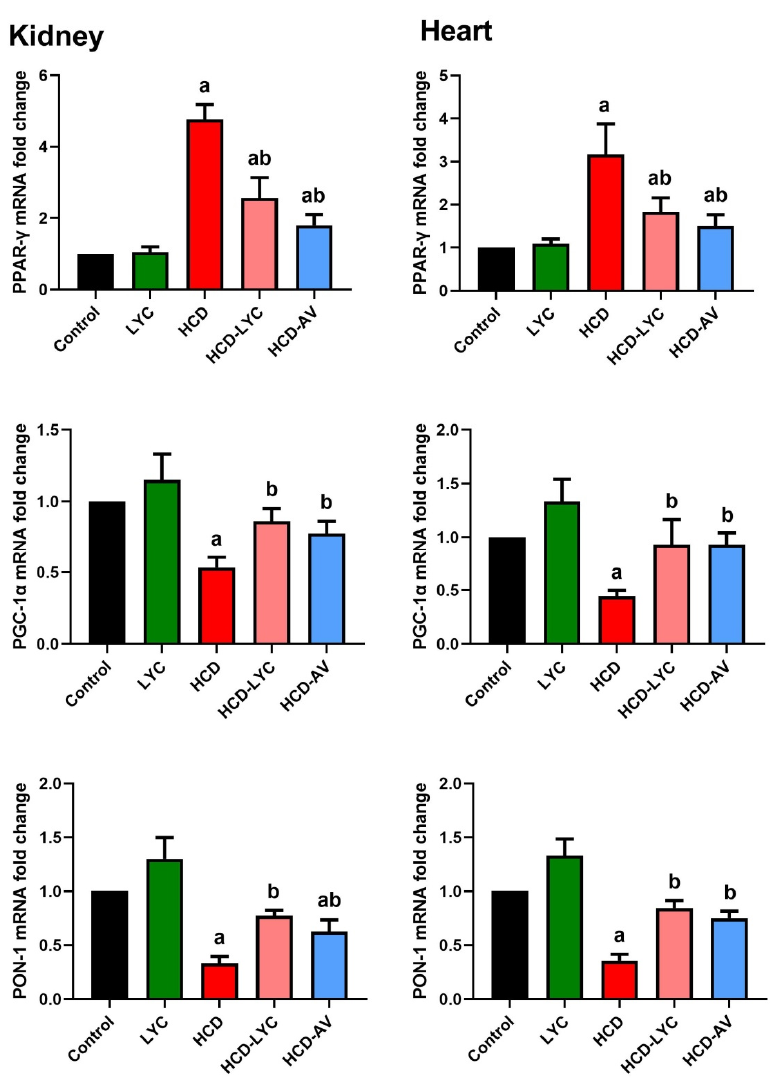
Figure 1. Effects of dietary cholesterol and lycopene on mRNA expression of peroxisome proliferator-activated receptor gamma (PPAR- γ ), PPAR- γ coactivator 1 alpha (PGC-1 α ), and paraoxonase 1 (PON-1) in cardiac and renal tissues in rats over 12 weeks. Letters a and b indicate statistically significant differences between control and HCD groups, respectively, at p < 0.05.